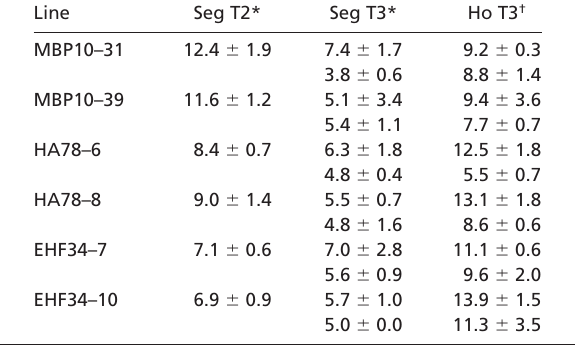
Table 1. Accumulation of scFv-Fc as a percentage of TSP content ( (cid:1) SD) in transgenic Arabidopsis seed stocks Line